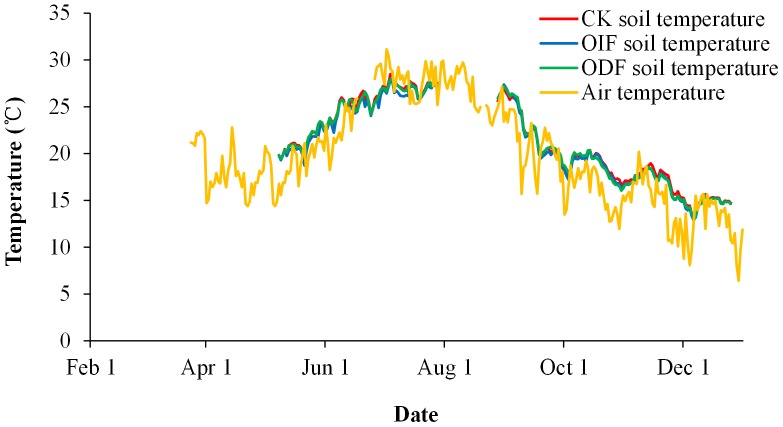
Daily average soil temperatures at 10(CK), optimal interval fertigation (OIF) and optimal daily fertigation (ODF) and daily average air temperature at 150 cm height in cucumber greenhouse cropping system in 2011 at Fangshan, Beijing suburbs.These data were determined by RTH-1010 TPE rensin-shield sensor and RT-12 Thermo Recorder made in Japan. Time interval for data recording was set to 10 minutes.